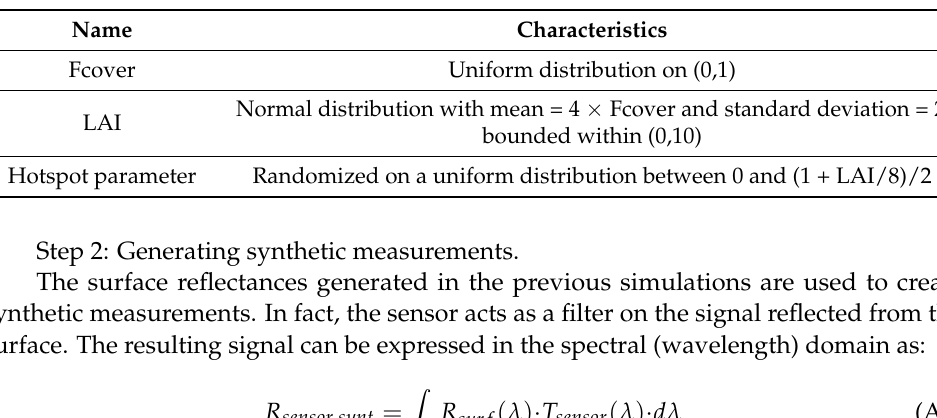
Table A1. Key parameters used to simulate the surface